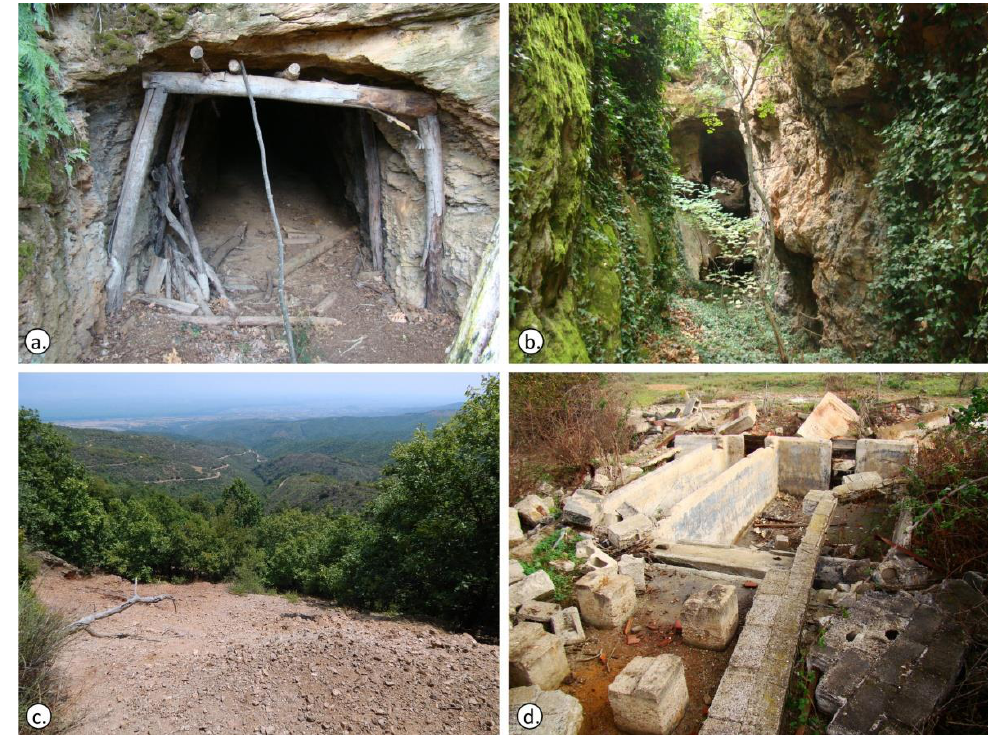
Figure 4. Photographs from the sampling survey: ( a ) The entrance of an old gallery; ( b ) A gallery parallel to the stibnite mineralization. Vertical wall rocks indicate the area of the exploited stibnite mineralization; ( c ) Waste material deposited downhill and opposite to a gallery entrance. ( d ) The destroyed floatation infrastructure near Zevgolatio village in the 1990s (Photo courtesy: Vasilios Melfos).